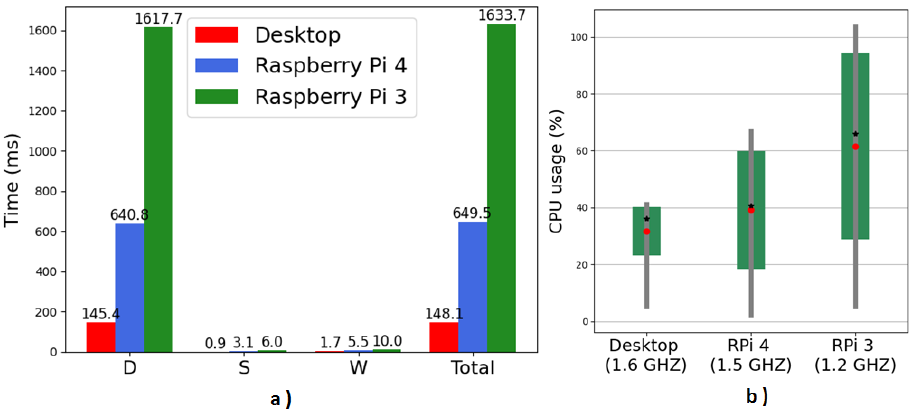
Figure 9. ( a ) The latency of executing SSA with different platforms; ( b ) the CPU usage of executing SSA with different